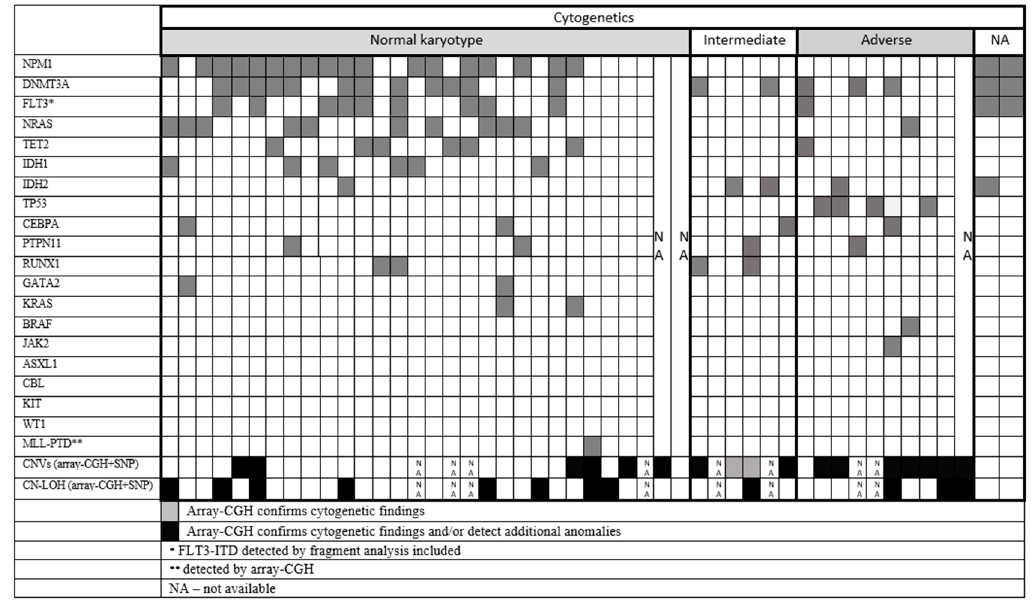
Figure 1. Summary of the genetic results illustrating the cooccurrences of different types of molecular